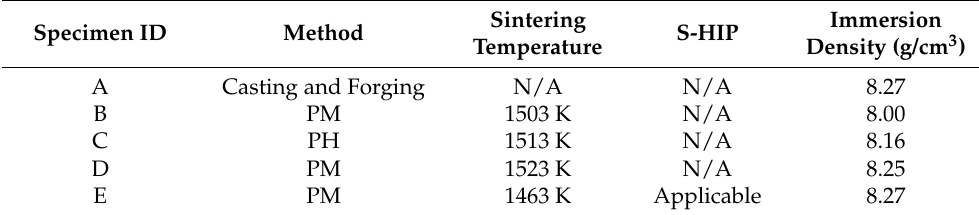
Table 2. Summary of prepared specimens.